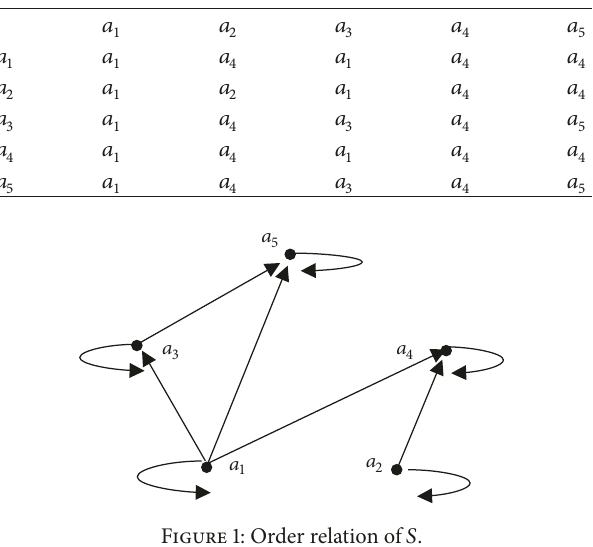
Figure 1: Order relation of 𝑆